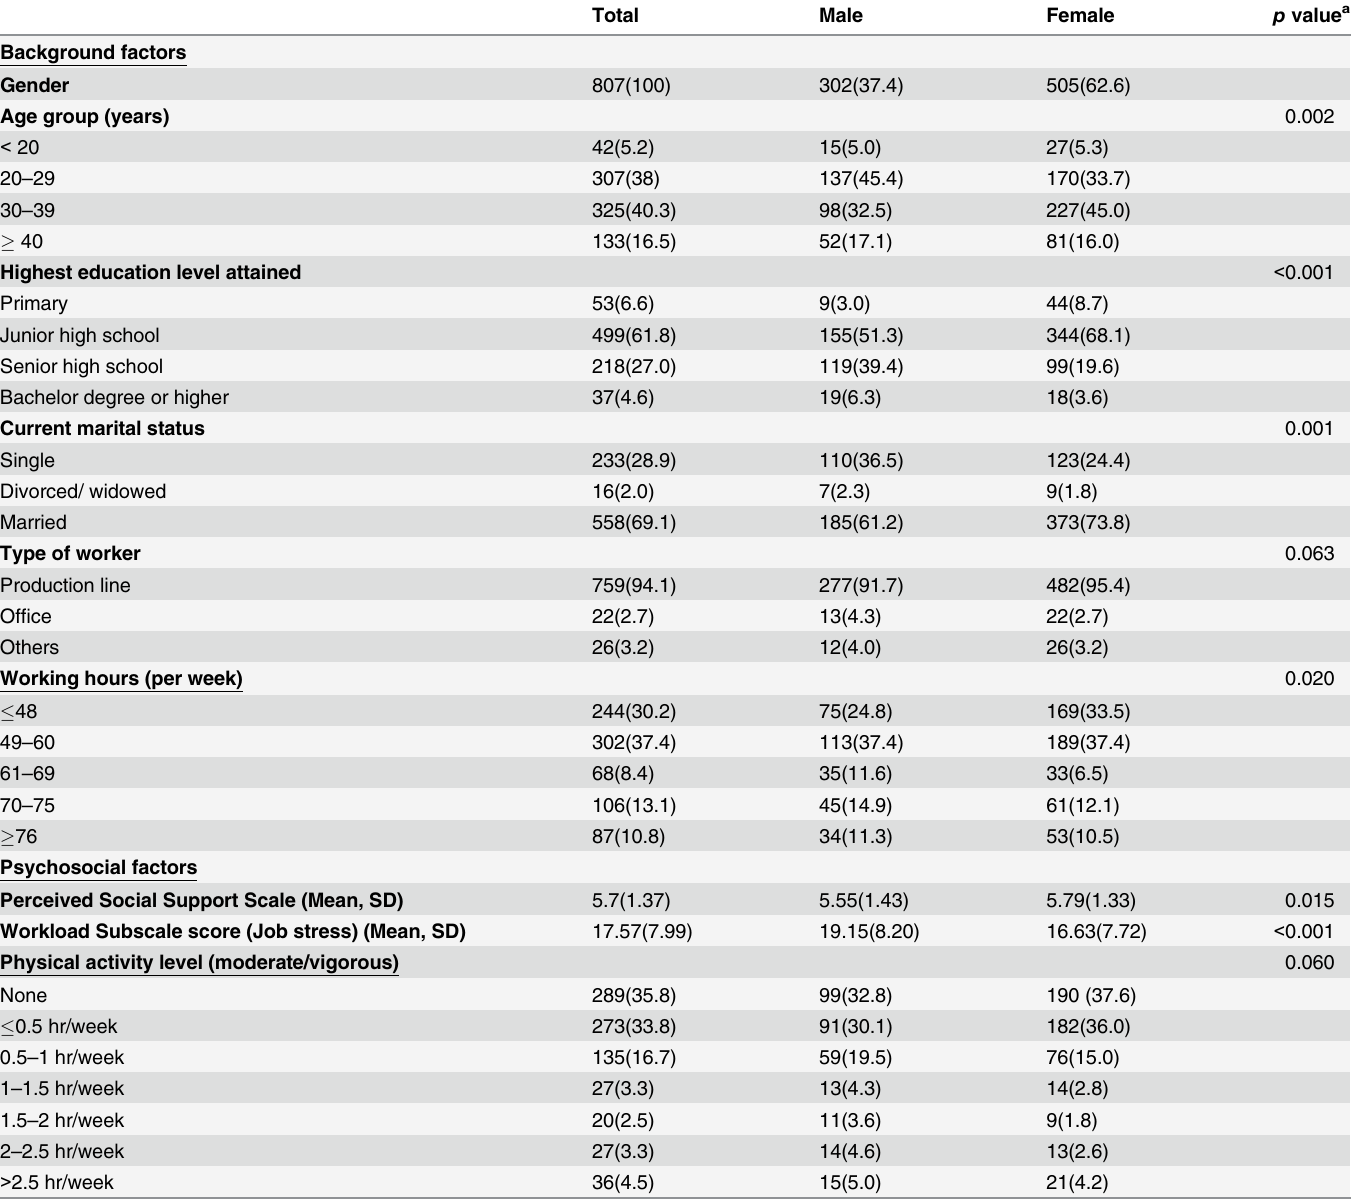
Table 1. Descriptive statistics by